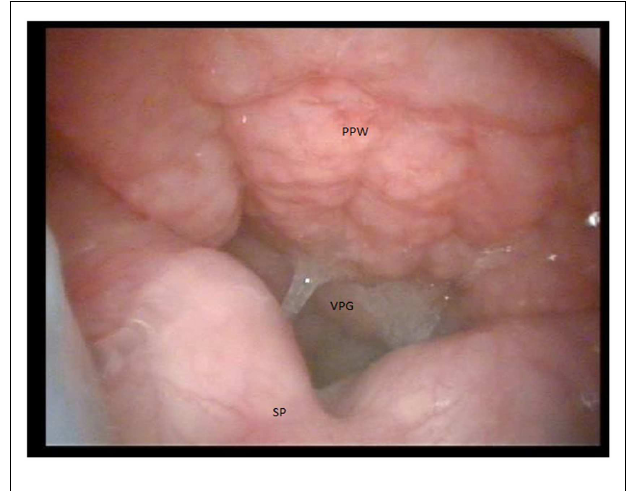
FIGURE 2 | Image of a persistent large velopharyngeal gap causing velopharyngeal insufficiency in a patient with 22q11.2 deletion syndrome undergoing video nasopharyngeal endoscopy (PPW = posterior pharyngeal wall,VPG = velopharyngeal gap, SP = soft palate)